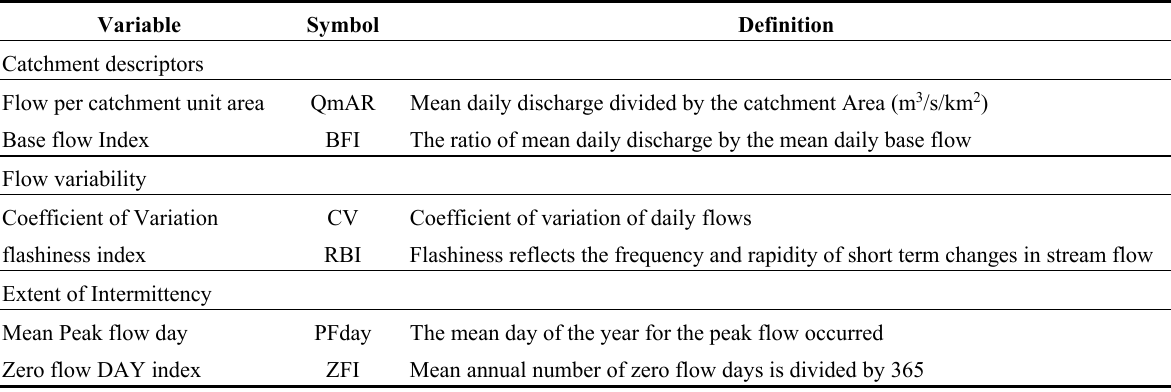
Table 1. Definitions of the hydrological variables derived for each